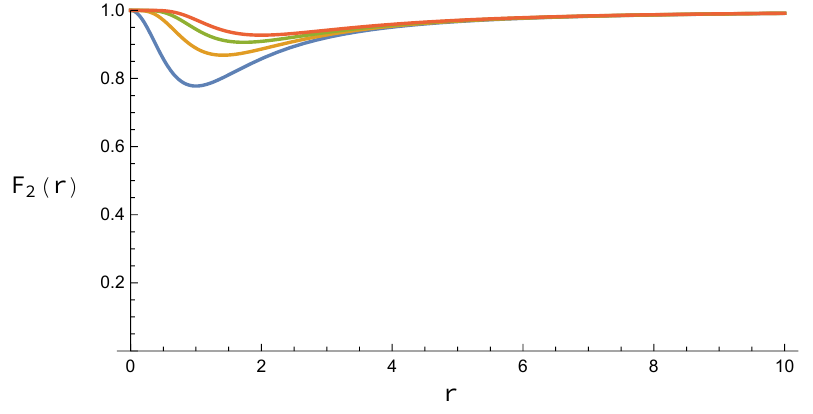
Figure 1 . Plot of F 2 ( r ) for a = 1, b = 4 and n = 1 ; 2 ; 3 ; 4. The curve with the largest dip has n = 1 and, as (4.17) implies, the size of the dip decreases with n